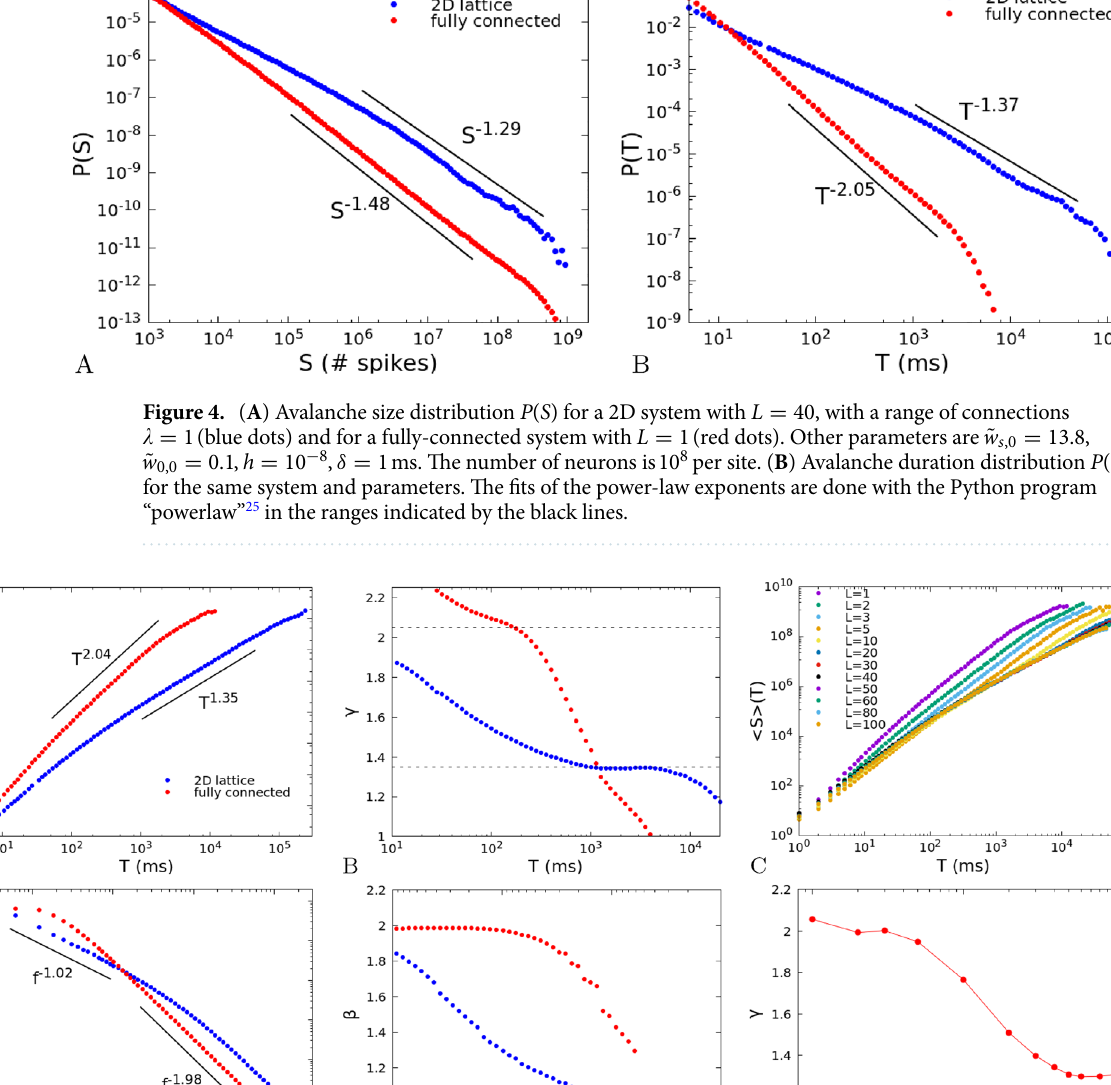
( T ) as a function of its duration, for the same system and S Figure 5. ( A ) Mean size of an avalanche (cid:31) (cid:30) ( T ) with a function T γ , in a sliding window S parameters of Fig. 4; ( B ) Exponent γ of a fit of (cid:31) (cid:30) ( T ) in panel (A), and used in Fig. 6 for the collapse of S dashed lines show the exponents given by the fits of (cid:31) (cid:30) ( T ) for many sizes between L S the avalanche shapes. ( C ) Same as in ( A ), but showing also (cid:31) (cid:30) ( D ) Power spectrum P ( f ) of the single site firing rate; ( E ) Exponent β of a fit of the power spectrum P ( f ) with 0.1 f , f a function f − β , in a sliding window . To make the comparison with panel B easier, the scale on the [ ] x -axis is inverted: high frequencies (small times) are on the left, low frequencies (large times) on the right, ( F ) ( T ) for different sizes of the lattice. The fit is restricted to mean sizes in the range S Exponent γ of the fit of (cid:31) (cid:30) 5 10 6 , 10 8 [ × ]